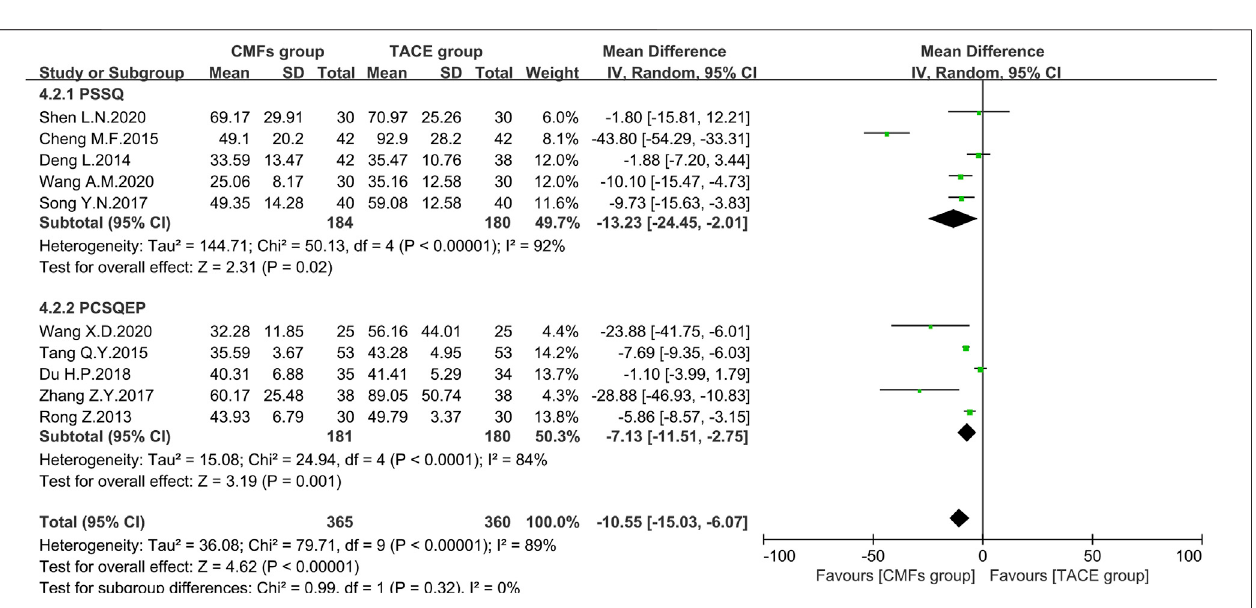
Frontiers in Pharmacology |